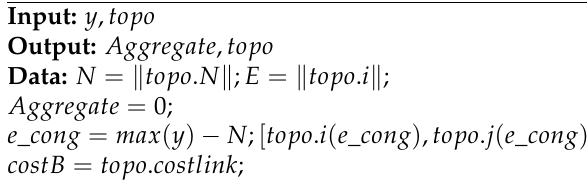
Algorithm 2 Secondary problem algorithm: Ψ